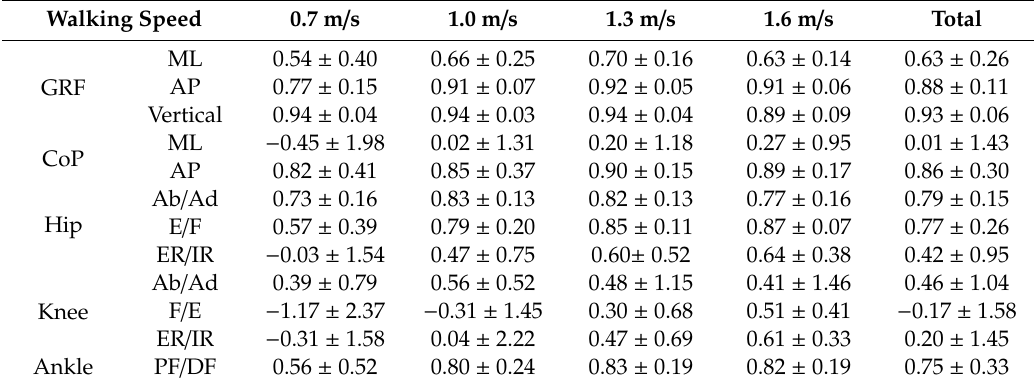
Table 4. R 2 values of GRF, CoP, and joint torques at each walking